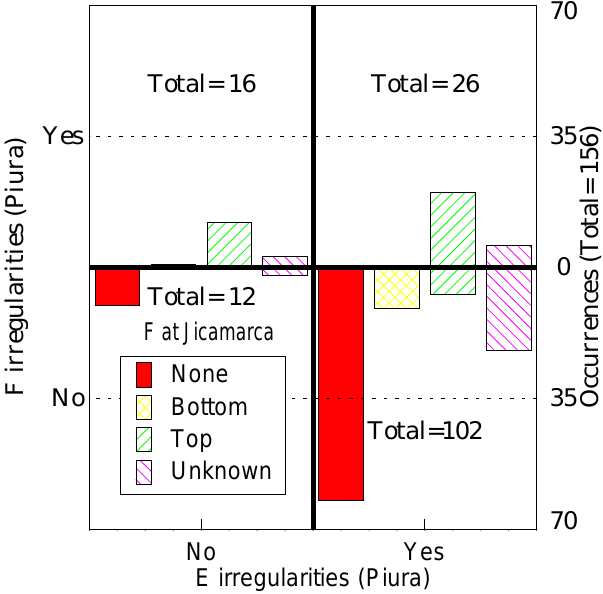
Fig.3. Occurrence correlation between E and F-region irregulari- ties observed over Piura and F-region irregularities observed over Jicamarca. These statistics have been obtained from 152 events ob- tained between 1991 and 1999. The different types of spread F events over Jicamarca are denoted with different